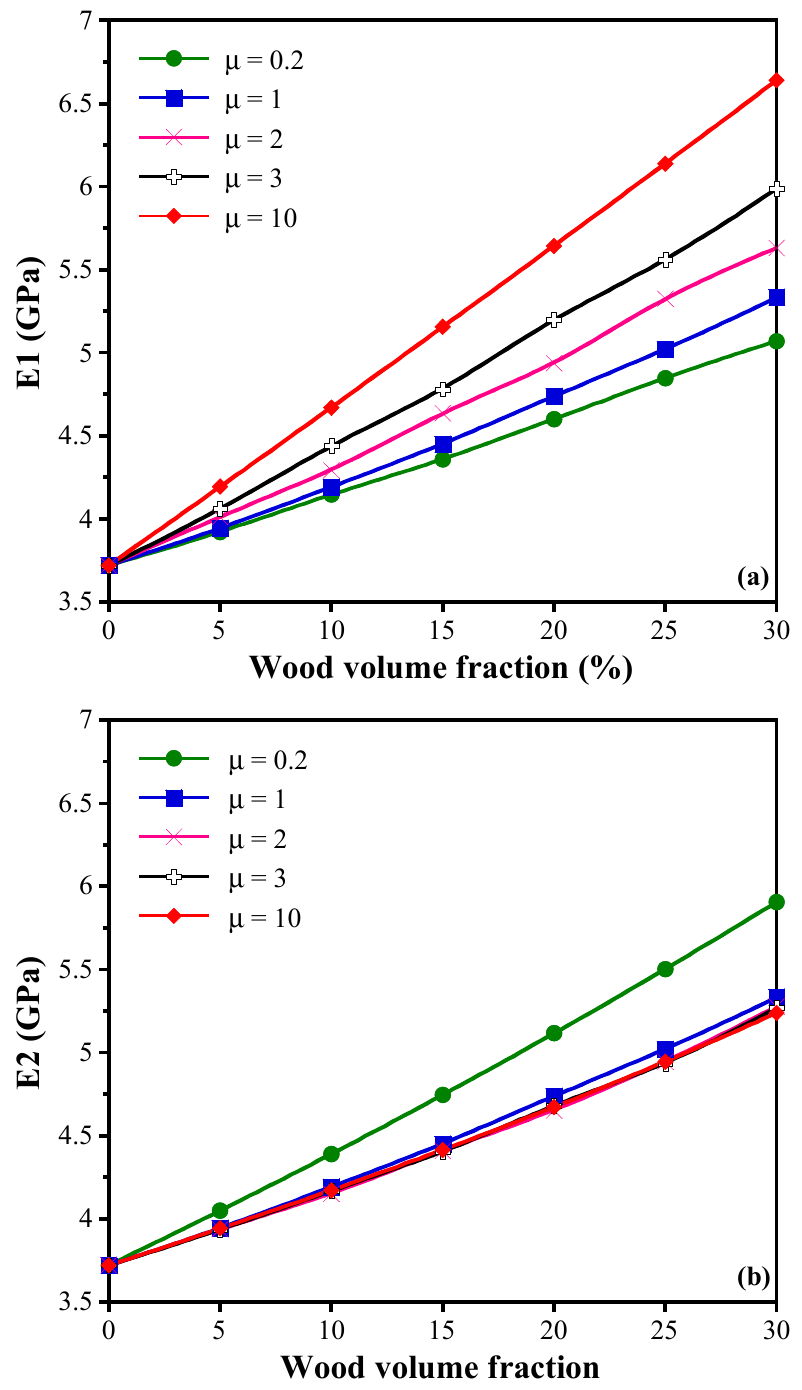
Figure 10. Variation of the effective Young’s modulus with change in aspect ratio—( a ) longitudinal modulus, ( b ) transversal modulus.